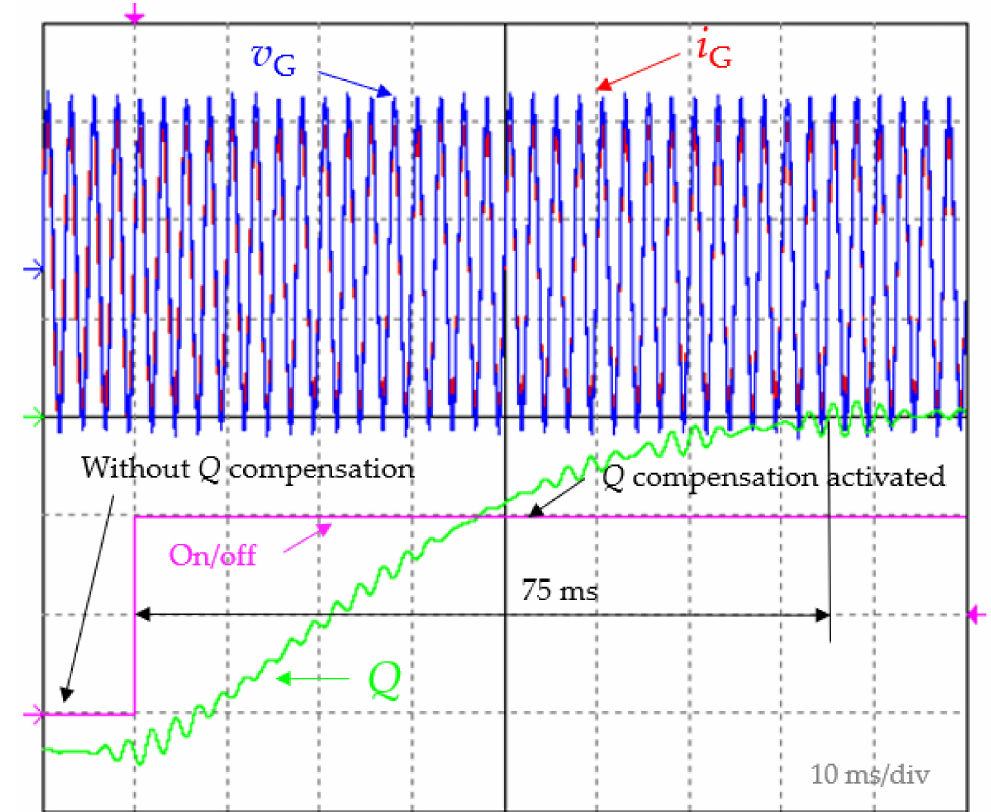
Figure 9. Dynamic response of the system to the activation of reactive power compensation: wave- forms of the grid voltage v G and grid current i G ; the reactive power Q ; the signal activating reactive power compensation On/off.